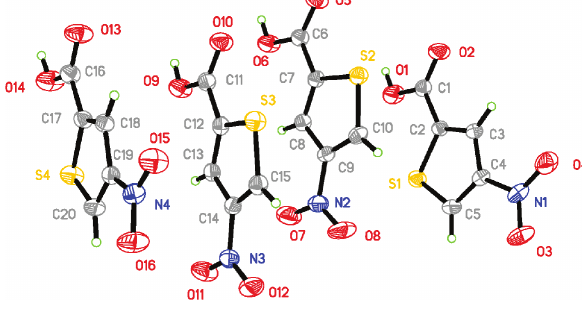
Table 1: Data collection and handling.